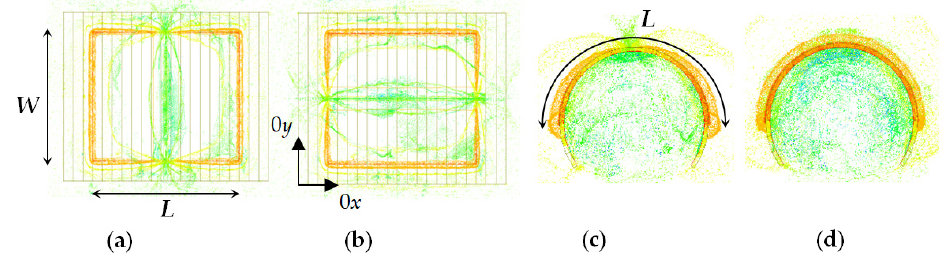
Figure 7. Simulated E-field pattern in microstrip resonators: ( a , b ) TM 10 and TM 01 in a flat resonator; ( c , d ) TM 10 and TM 01 in a bent resonator. Legend: L —length; W —width.